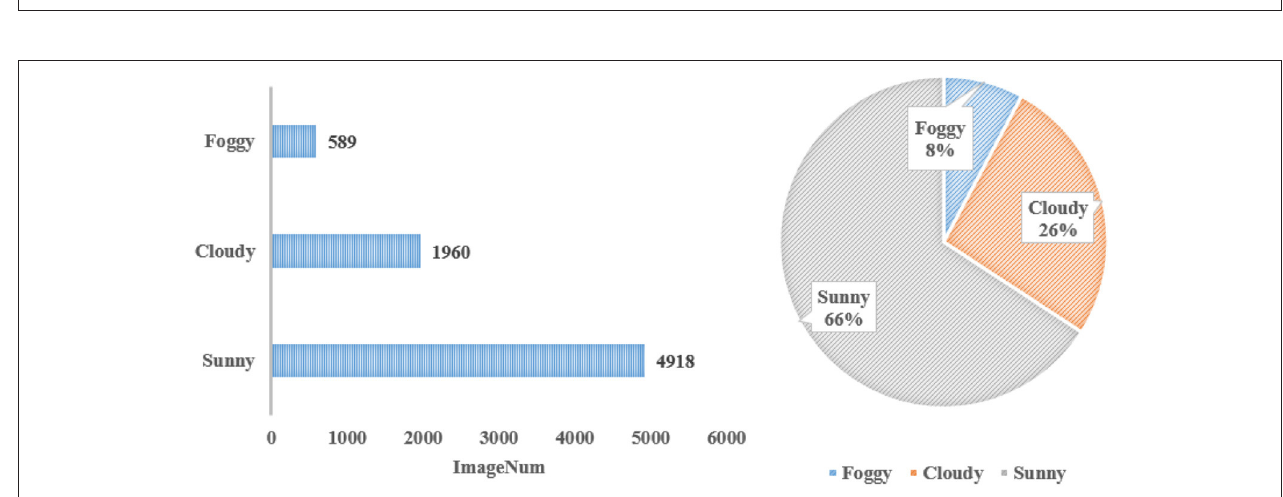
FIGURE 4 | Statistics under different climate conditions.